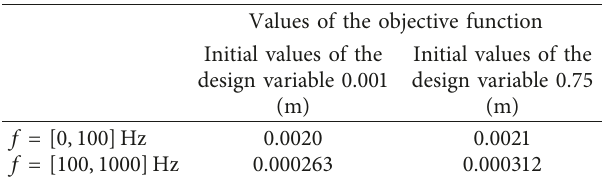
Table 4: The values of the objective function of the optimal layouts of CLD treatment. Values of the objective